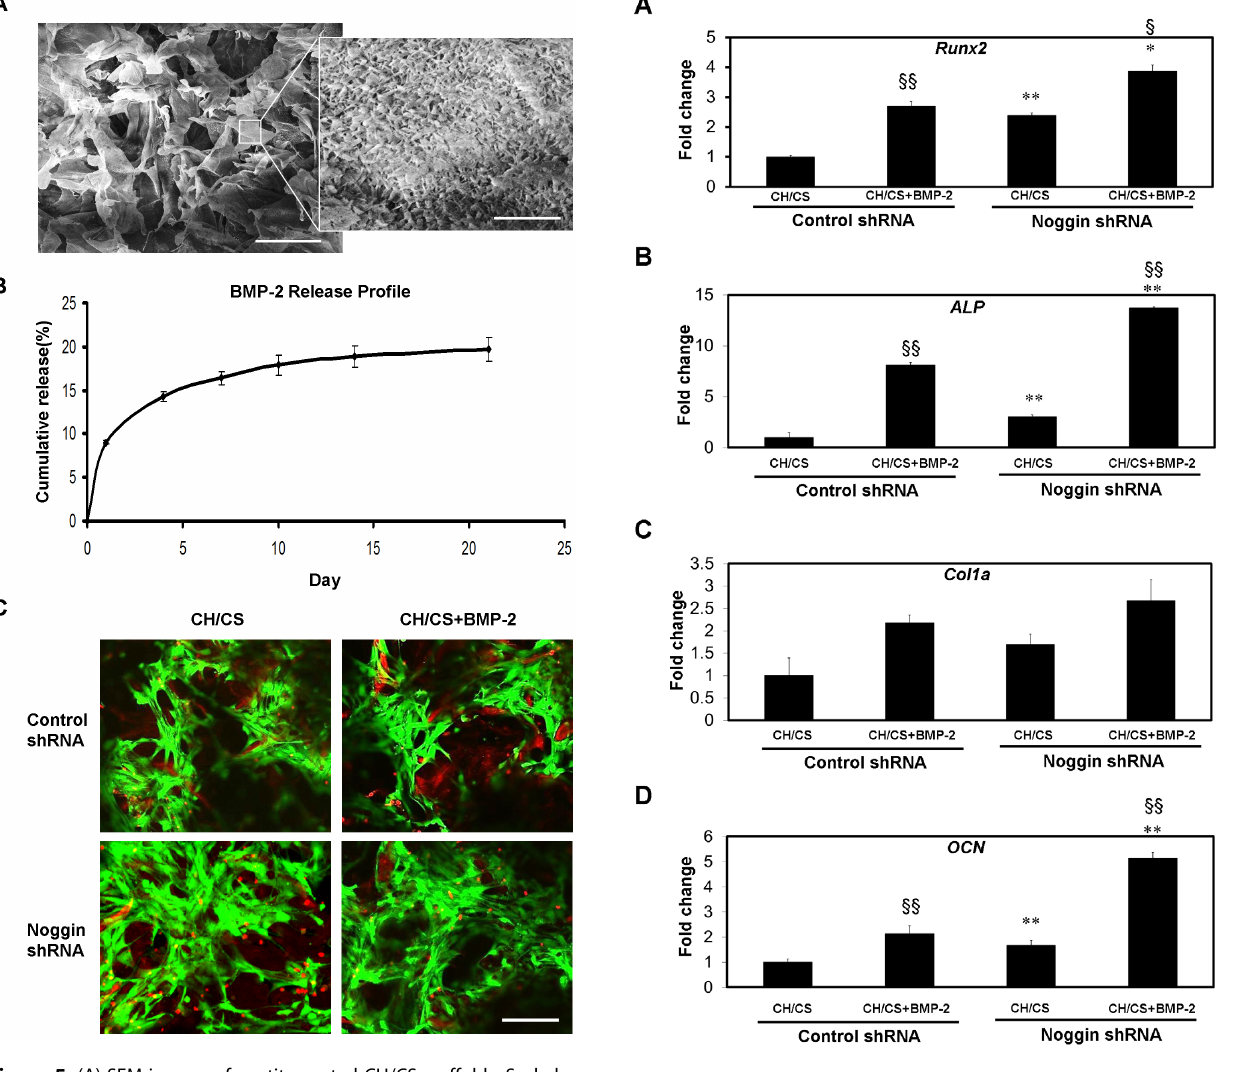
Figure 6. Osteogenic gene expression of ASCs cultured in apatite-coated CH/CS scaffolds releasing BMP-2. Osteogenic gene markers including Runx2 (A), ALP (B), Col1a (C) and OCN (D) were evaluated in noggin suppressed ASCs cultured on CH/CS scaffolds for 14 days as assessed by quantitative real-time PCR. (* p , 0.05, ** p , 0.01 compared to their corresponding controls transduced with control shRNA). Significant up-regulation of genes including Runx2 , ALP and OCN was observed in ASCs cultured on CH/CS scaffolds releasing BMP-2 ( 1 p , 0.05, 11 p , 0.01).